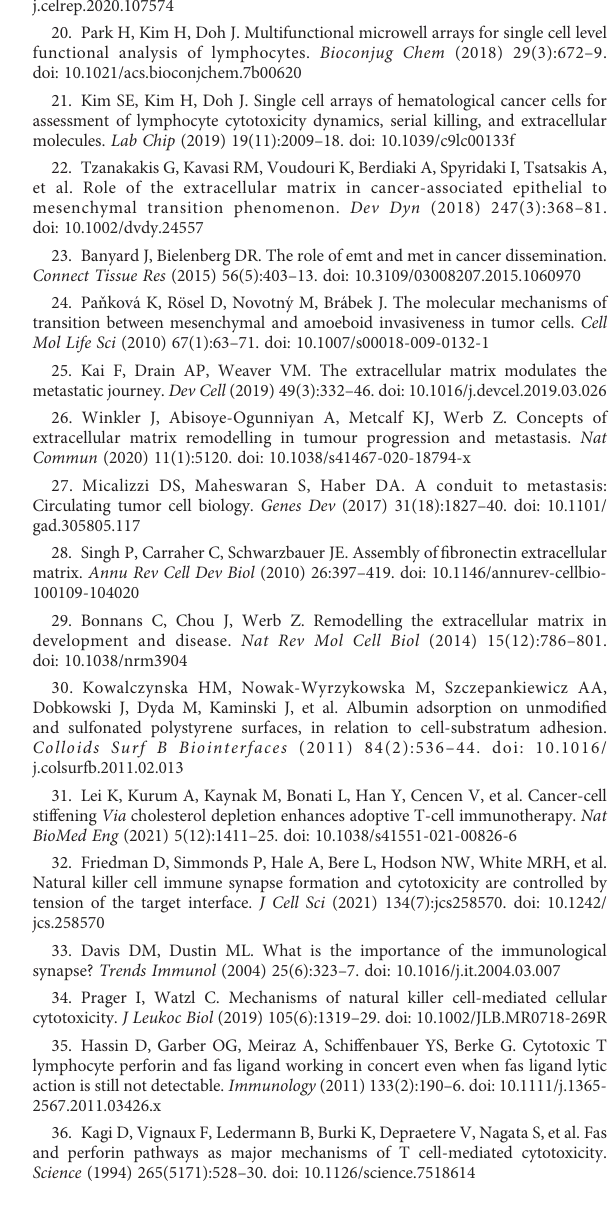
SUPPLEMENTARY VIDEO S1 A representative movie showing an NK-92 cell (yellow boundary) interacting with a HeLa cell (blue labeled with white boundary) in a BSA-coated microwell. Scale bars: 10 m m. Time stamp: hh:mm. SUPPLEMENTARY VIDEO S2 A representative movie showing an NK-92 cell (yellow boundary) interacting with a HeLa cell (blue labeled with white boundary) in a FN- coated microwell. Scale bars: 10 m m. Time stamp: hh:mm.